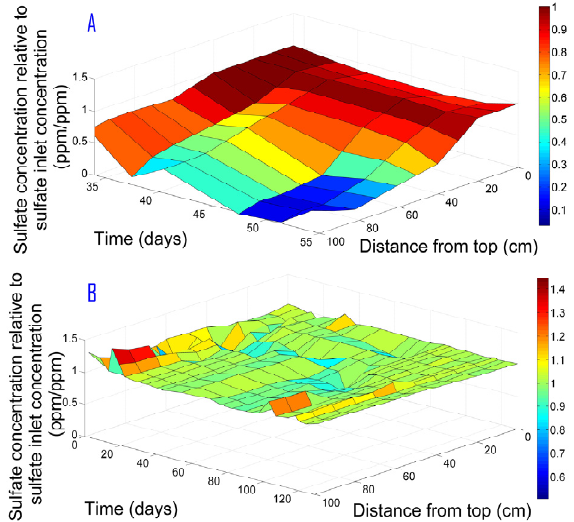
Figure 7. Sulfate concentration relative to its inlet concentration as a function of time and distance along the column in ( A ) Phase I and ( B ) Phase II.